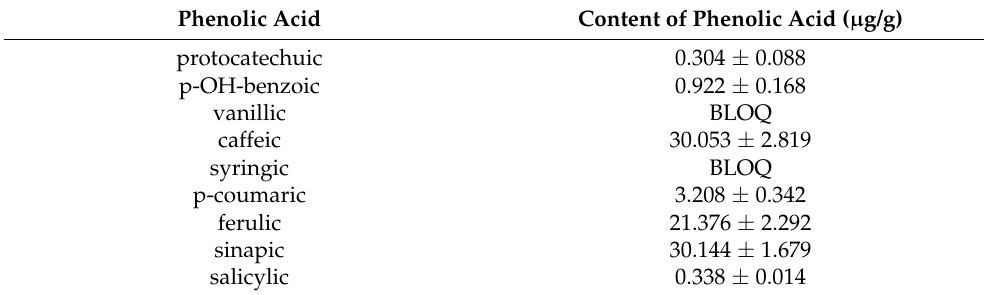
Table 5. Phenolic acid contents in snack pellets with a 30% content of fresh kale (36% mc, 100 rpm) (n = 3; mean ±